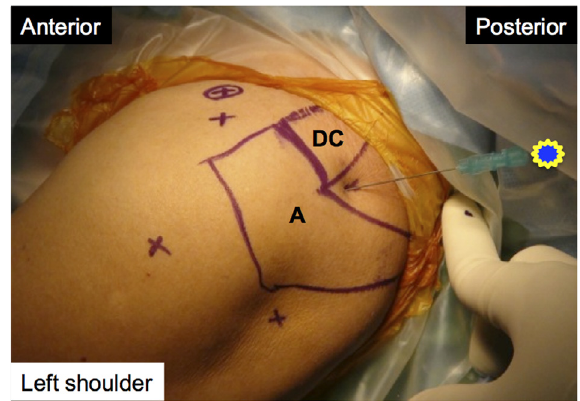
Figure 3. Anterior technique. AC: acromioclavicular joint; C: coracoid; LT: lesser